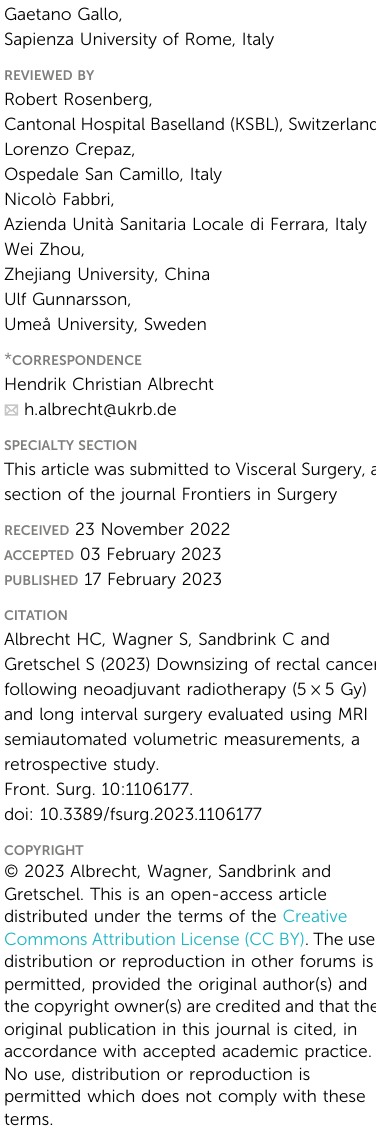
and long interval surgery evaluated using MRI semiautomated volumetric measurements, a retrospective